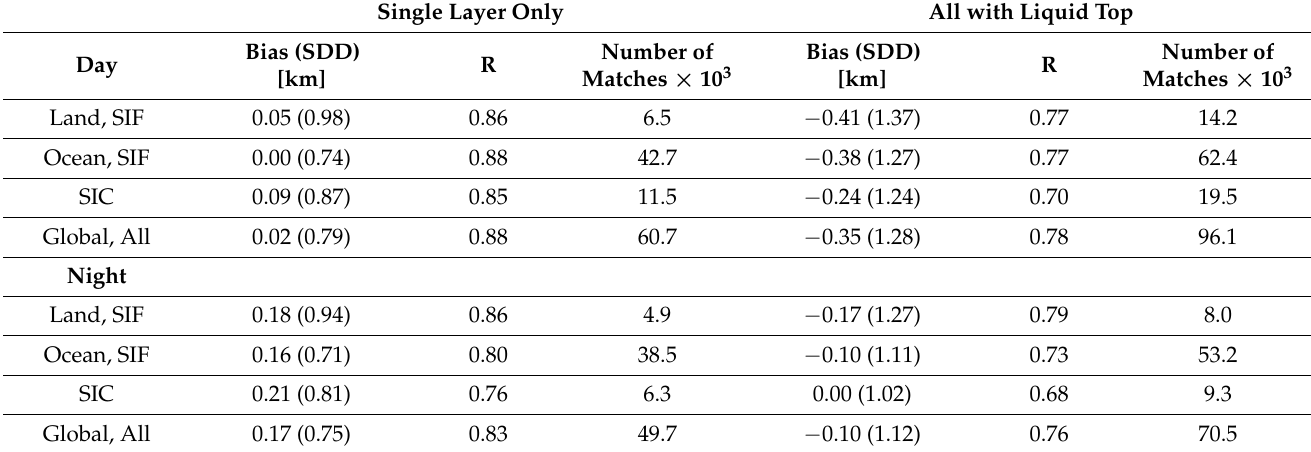
Table 4. Differences between CERES SNPP VIIRS Ed1a and CALIPSO cloud top heights for all over- cast (0/100) liquid clouds identified by CALIPSO, JAJO 2015 and 2016. Biases are computed as Figure 7 maps the regional mean differences, CTH V − CTH C , for SLP and the liquid VIIRS—CALIPSO. dominant clouds. Despite using a 30 min window ( ± 15 min) for collocation, the